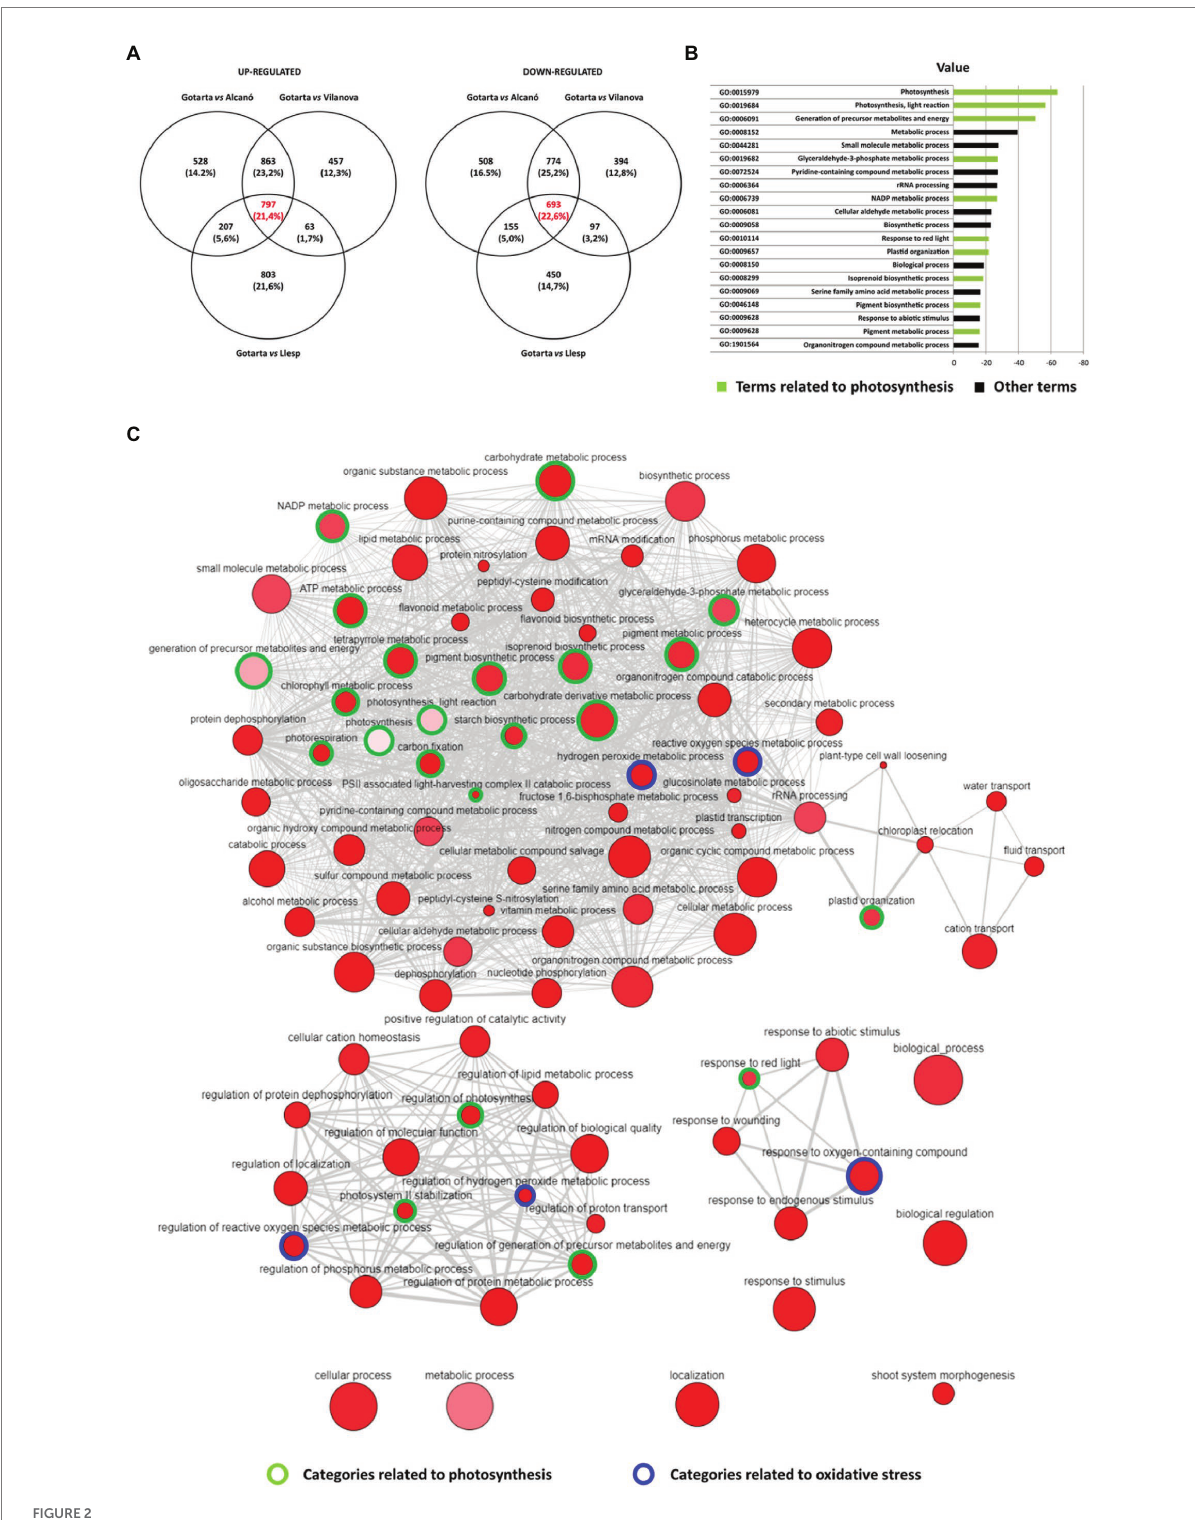
FIGURE 2 Number of genes upregulated and down-regulated (A) in Gotarta apples (yellow phenotype) compared with the other 3 orchards (green phenotypes). The 20 most frequent GO upregulated in Gotarta were displayed as % Total GO counted (B) . Gene functional categories enriched in Gotarta apples (C) provided by REVIGO’s “Scatterplot view” (http://revigo.irb.hr/). Disc color indicates enrichment value of p (the softer the color the highest the value) and size represents the frequency of the category. Thickness of grey lines represent semantic similarity between categories while spatial arrangement of discs corresponds to grouping of categories by semantic similarity. Those related to photosynthesis are circled in green, and terms associated with oxidative stress are circled in